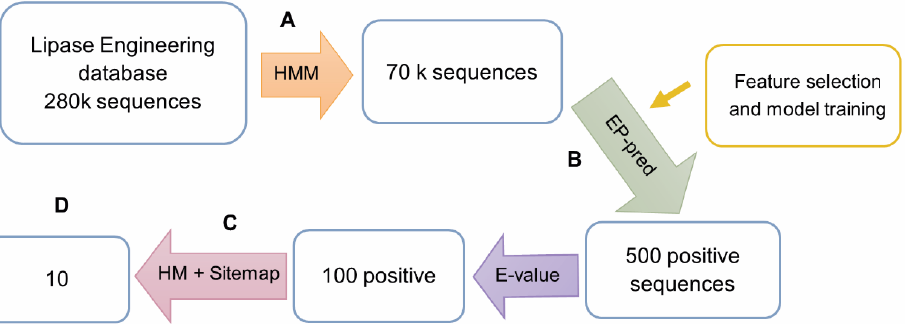
Figure 3. A description of the bioprospecting workflow. A, Since there was a mix of different families in LED, first we applied an HMM profile created from the esterase dataset to clean the database and keep only esterases. B, EP-pred evaluated the remaining sequences and predicted around 500 positive hits. C, The top 100 sequences according to E-values returned by HMM in step A were isolated and analyzed according to molecular descriptors from homology modeling (HM) and Sitemap calculations. D, A final set of 10 sequences with the highest hydrophobicity and enclosure/exposure scores were gathered and sent to be validated